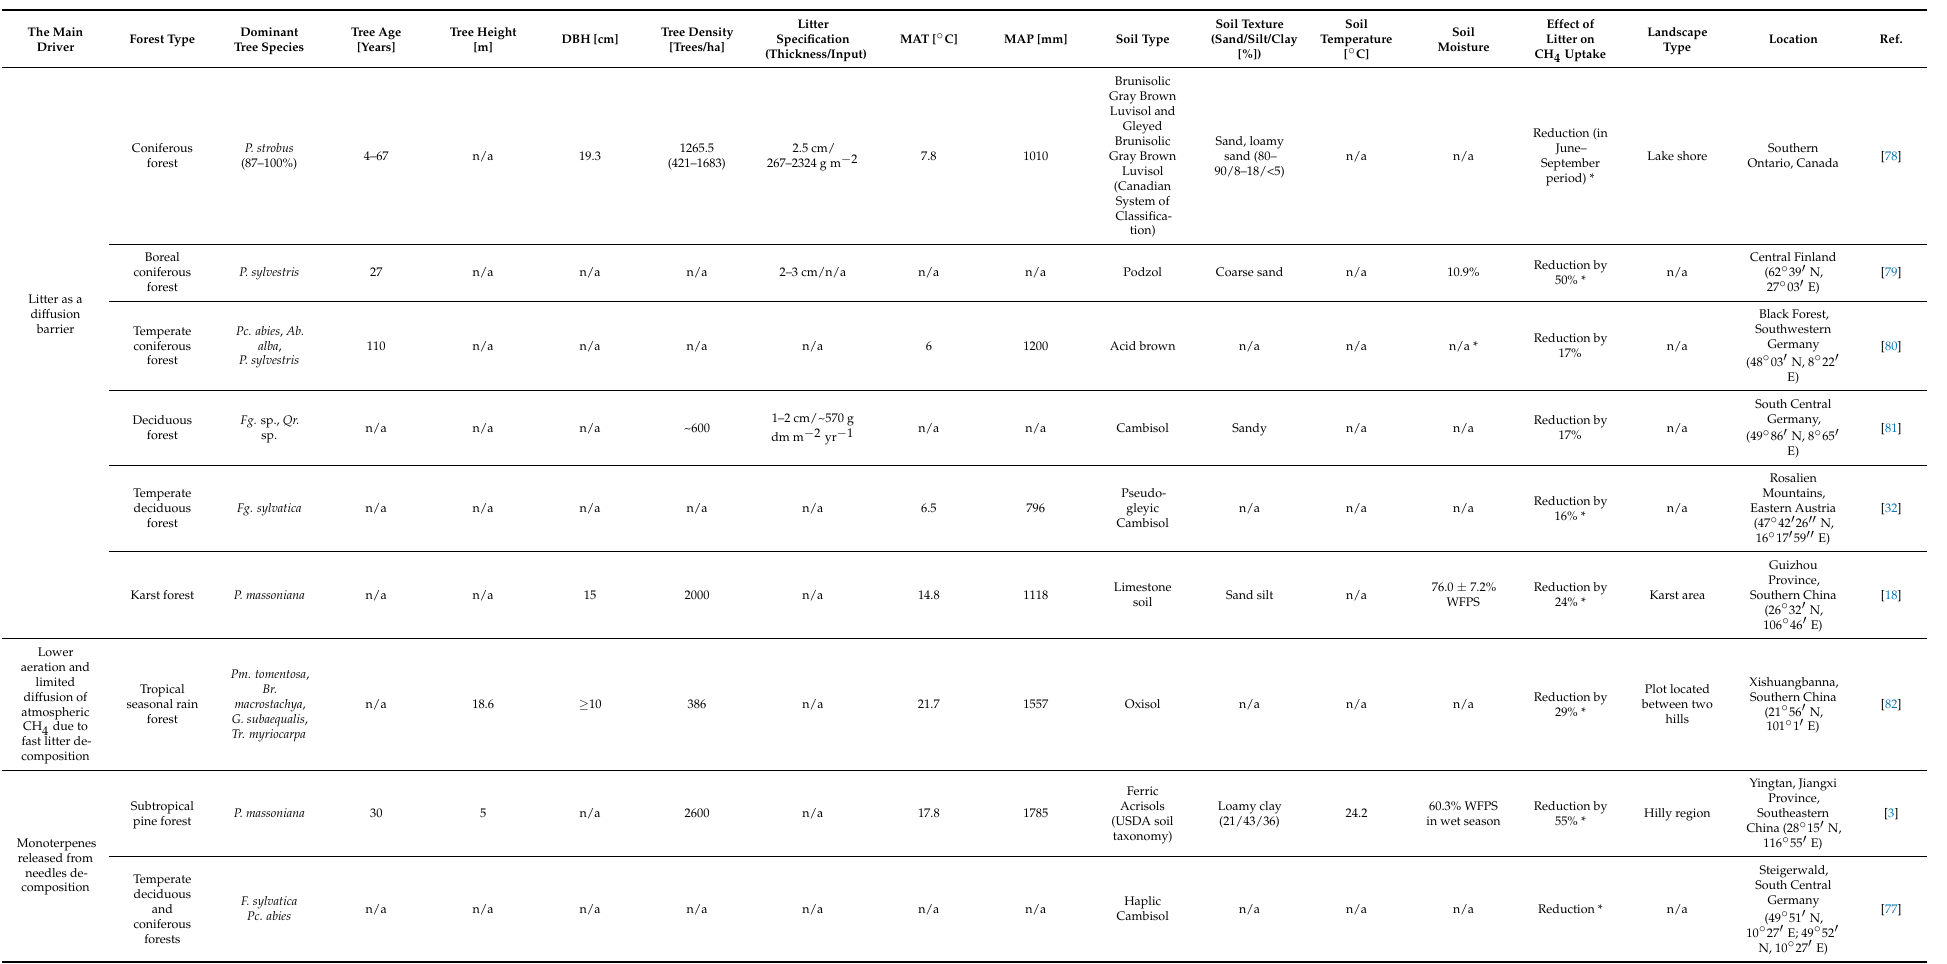
Table 2. The main litter-related drivers of CH 4 uptake in different forest soils from different regions based on field studies (except [77]—laboratory incubations). TheMain